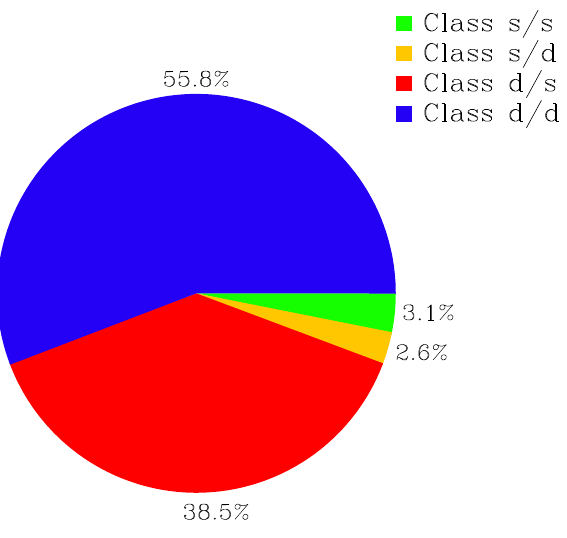
Figure 7. Fraction of galaxy clusters and groups that can be described best by a single Maxwell distribution and a single Sérsic profile (class s/s; green), a double Maxwell distribution and a single Sérsic profile (class d/s; red), a single Maxwell distribution and a double Sérsic profile (class s/d; yellow), and a double Maxwell distribution and a double Sérsic profile (class d/d;